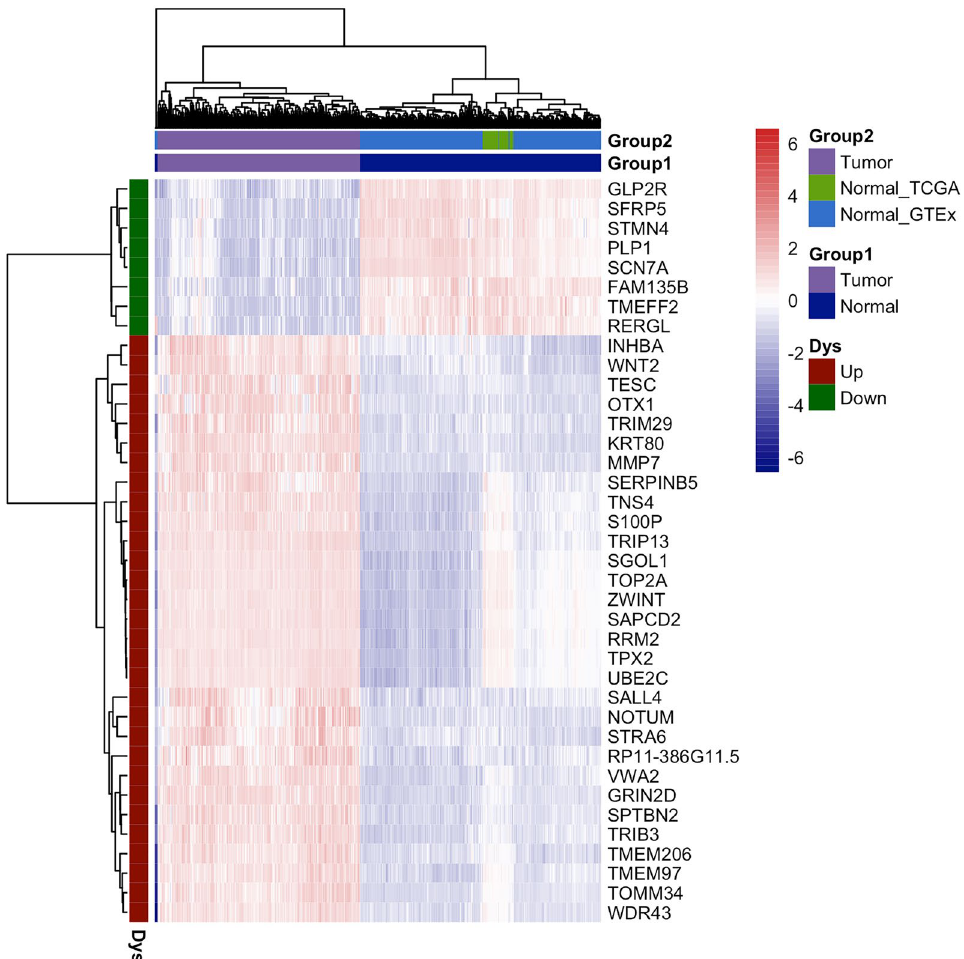
Figure 3. Bi-clustering analysis of the 38 genes that were screened using feature selection. The analysis was carried out in R using the “pheatmap” package. All of the samples were mainly divided into two groups: tumor and normal, with the latter including normal_TCGA and normal_GTEx subgroups. The samples and genes were represented by the horizontal and vertical axis,